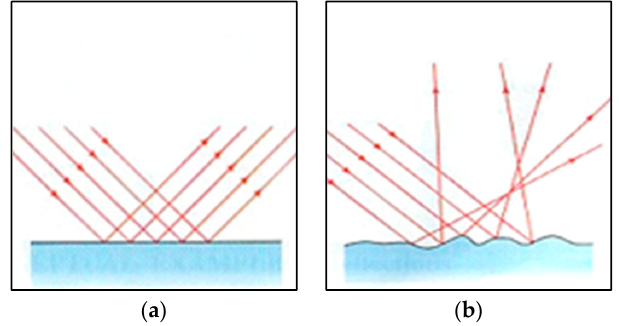
Figure 1. Reflection — sound physical phenomenon. ( a ) Specular reflection phenomenon. ( b ) Diffuse reflection phenomenon.